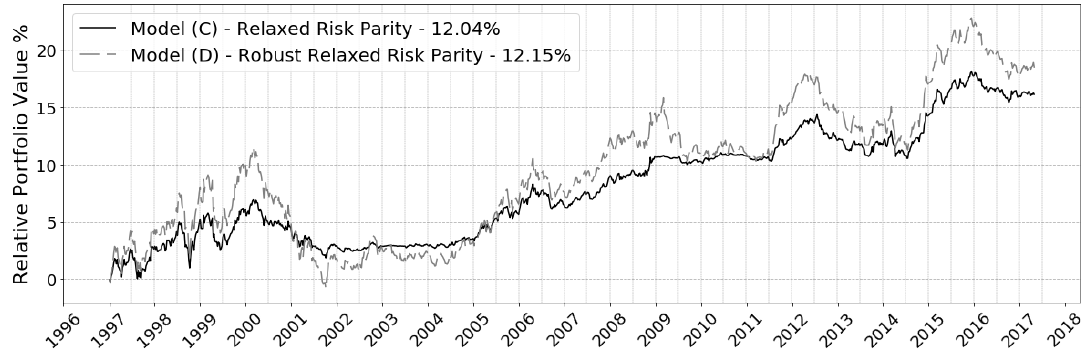
Figure 15. Out-of-sample relaxed risk parity to robust—1997–2018.